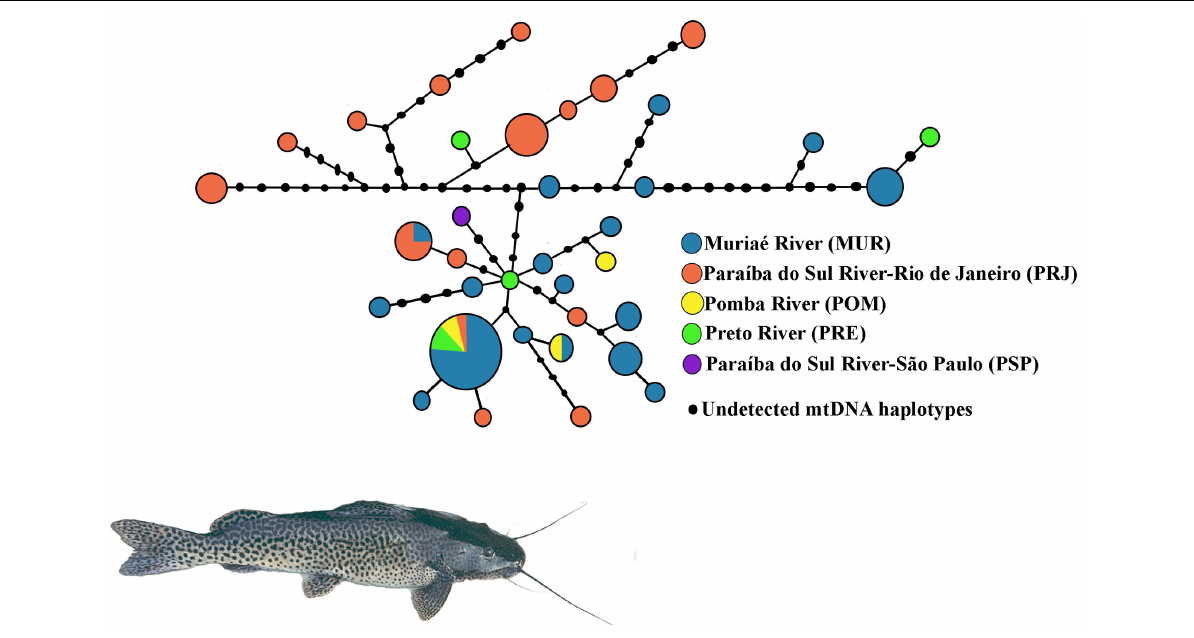
Frontiers in Genetics |